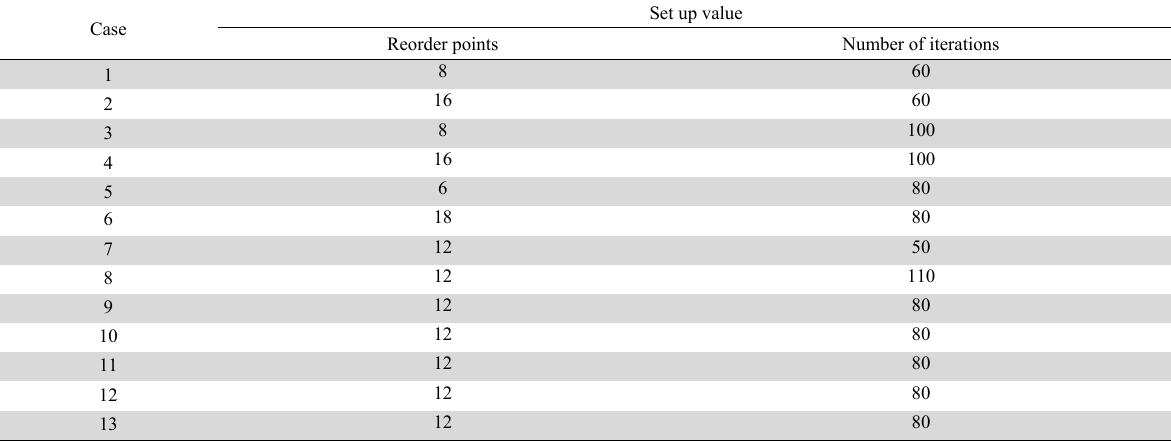
Combination of factors for CCD experimental